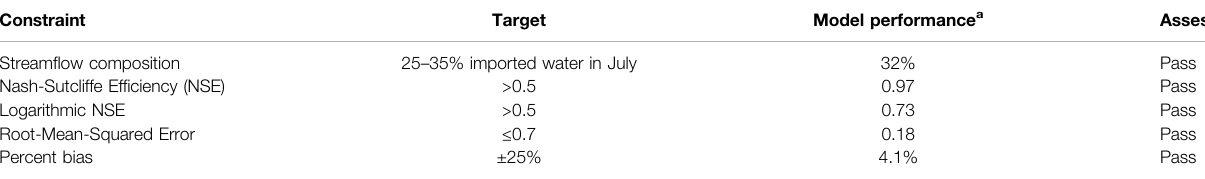
TABLE 2 | Calibration targets and hydrologic model performance at the lower Aliso Creek gauge.